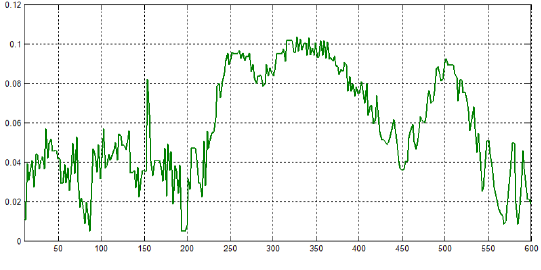
Figure 17. Specific difference of path